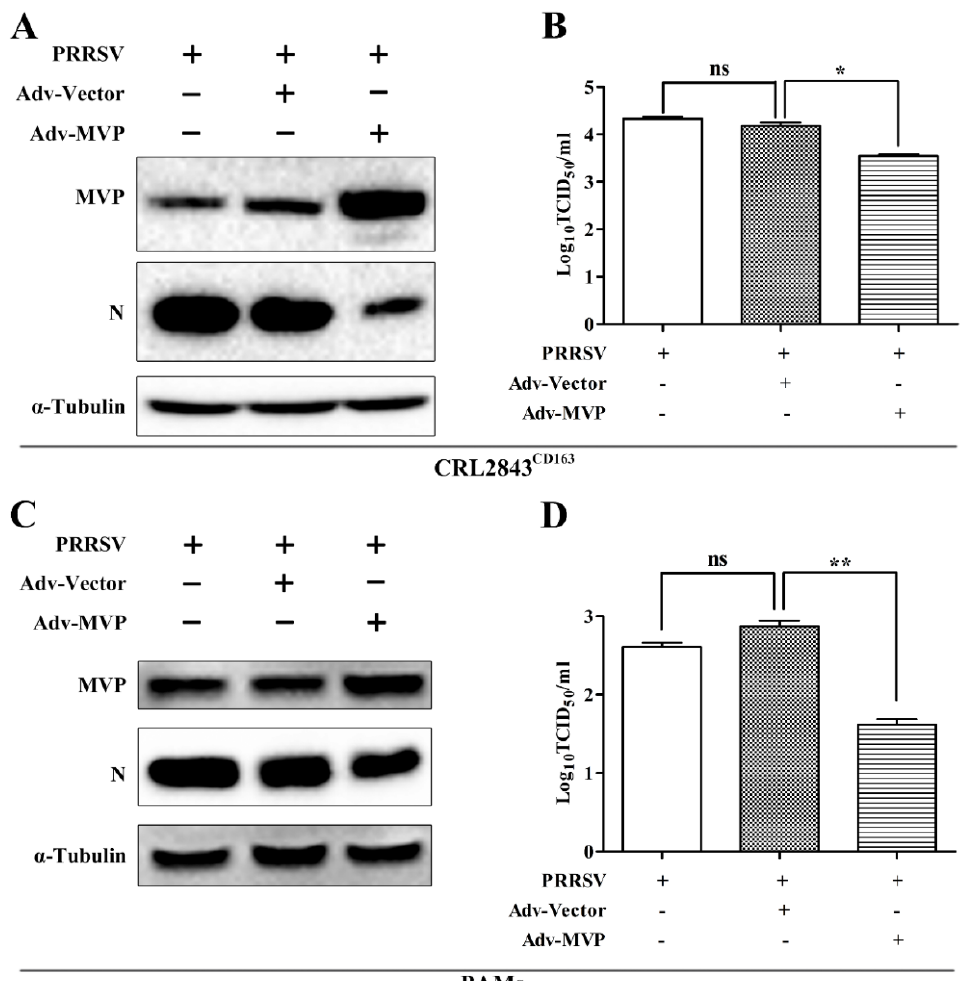
Figure 2. MVP overexpression inhibited PRRSV replication in CRL2843 CD163 cells and PAMs. After infection with Adv– Vector or Adv–MVP (MOI = 5) for 24 h or 12 h, CRL2843 CD163 cells or PAMs were infected with GD-HD PRRSV at an MOI of 1 or 0.1 for 48 h or 24 h, respectively. The protein expression levels of MVP and PRRSV N were detected by Western blot ( A , C ). Virus titers from cell supernatants were measured by TCID 50 ( B , D ). The α -tubulin was used as internal loading controls in Western blot analysis. Data from three independent experiments are expressed as the means ± SD. The analysis of differences between the means was performed using ANOVA and is marked by ns (no significant), * ( p < 0.05), and ** ( p <